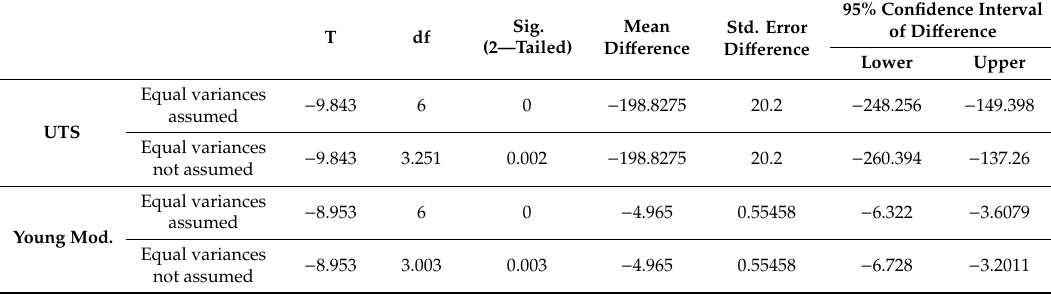
Table A4. T -test for equality of means between coconut and silk.